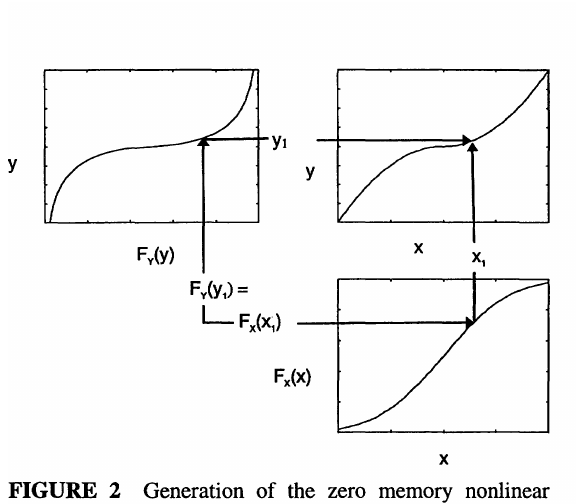
FIGURE 2 Generation of the zero memory nonlinear function transformation function, y =